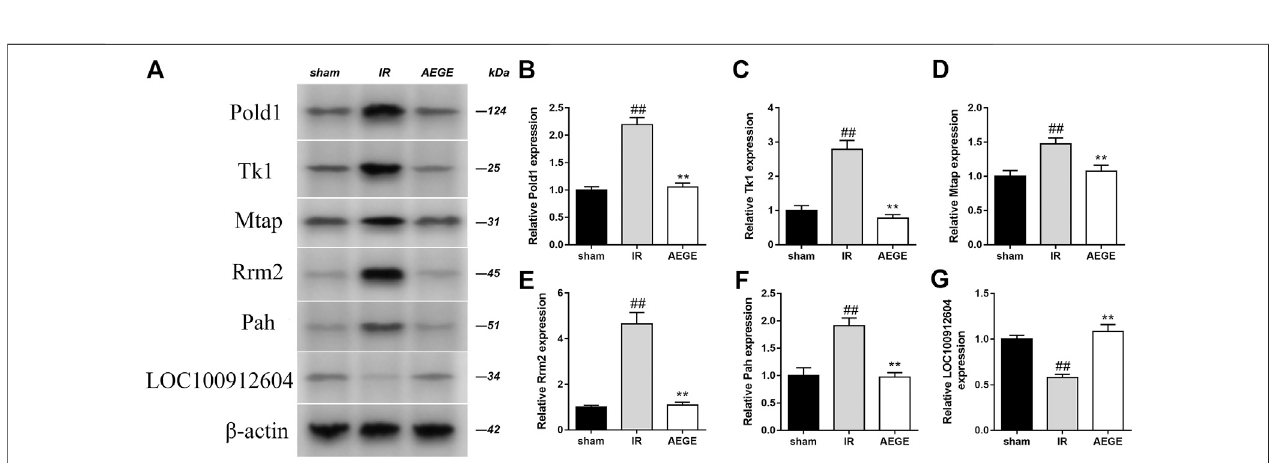
FIGURE 5 | Determination of protein levels in brain tissue of rats in the sham, CIR, and AEGE groups. Expression of Pold1 (A,B) , Tk1, (A, C) , Mtap (A,D) , Rrm2 (A,E) ,Pah (A,F) ,andLOC100912604 (A,G) ontheindicatedgroupweredetectedusingwesternblotting.Resultsareexpressedasmean ± SDforthreeindividual experiments which, were performed in triplicate for each condition. “ # ” represents sham group vs. the IR group (## p < 0.01); represents IR group vs. the AEGE group (** p < 0.01).